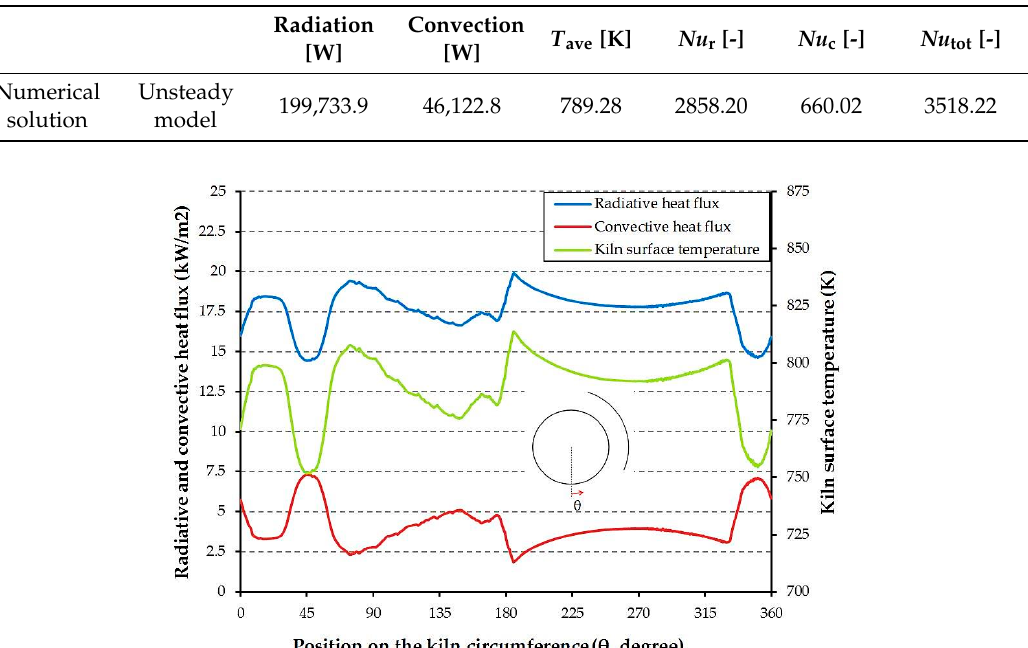
Figure 8. Local radiative heat flux, convective heat flux, and temperature distribution on the kiln while heat flux on the kiln is constant.